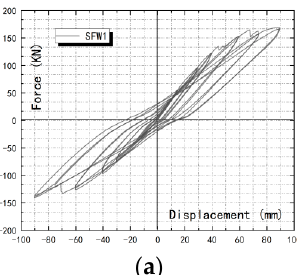
( b ) Figure 12. Skeleton curves of SFW1 and SFW2 ( a ) and SFW1 and SFW3 ( b ). In the early stage (5–40 mm cycle), the trends in the skeleton curves of the three groups basically overlapped. SFW1 was larger than SFW2 and SFW3, indicating that both specimens were in the elastic stage. However, because the bolts of the new connectors of SFW2 and SFW3 slid in the limitation holes with loading, their load capacity and stiffness were less than that of the L-hooked bolt connector (SFW1), which means the new con- nector effectively released the energy. In the intermediate stage of the test (40–75 mm cy- cle), the partial rigidity of the new connector (SFW2 and SFW3) was only demonstrated after the displacement of the new connector bolt at the limitation hole had reached its limit. Due to the rigid connection of SFW1 entered the yielding stage first, the rise in the load-carrying capacity of SFW1 became flat as the displacement loading was exceeded by SFW2 and SFW3. At this point, the new connectors (SFW2 and SFW3) started to contribute stiffness to the frame, making the frames’ load capacity higher. During the later 75–90 mm cycle stage, each of the specimens was in the yielding stage. The curve for SFW1 fluctuated suddenly, then rapidly started to decrease to a value much smaller than those for SFW2 and SFW3. This was because as the weld of the L-hooked bolt (SFW1) with the angle steel broke at 75 mm loading, the connection type of SFW1 became too flexible overall, and the stiffness contribution of the frame decreased rapidly. The bearing capacity of the L- hooked bolt started to reach its peak, then rapidly entered the damage phase, which was